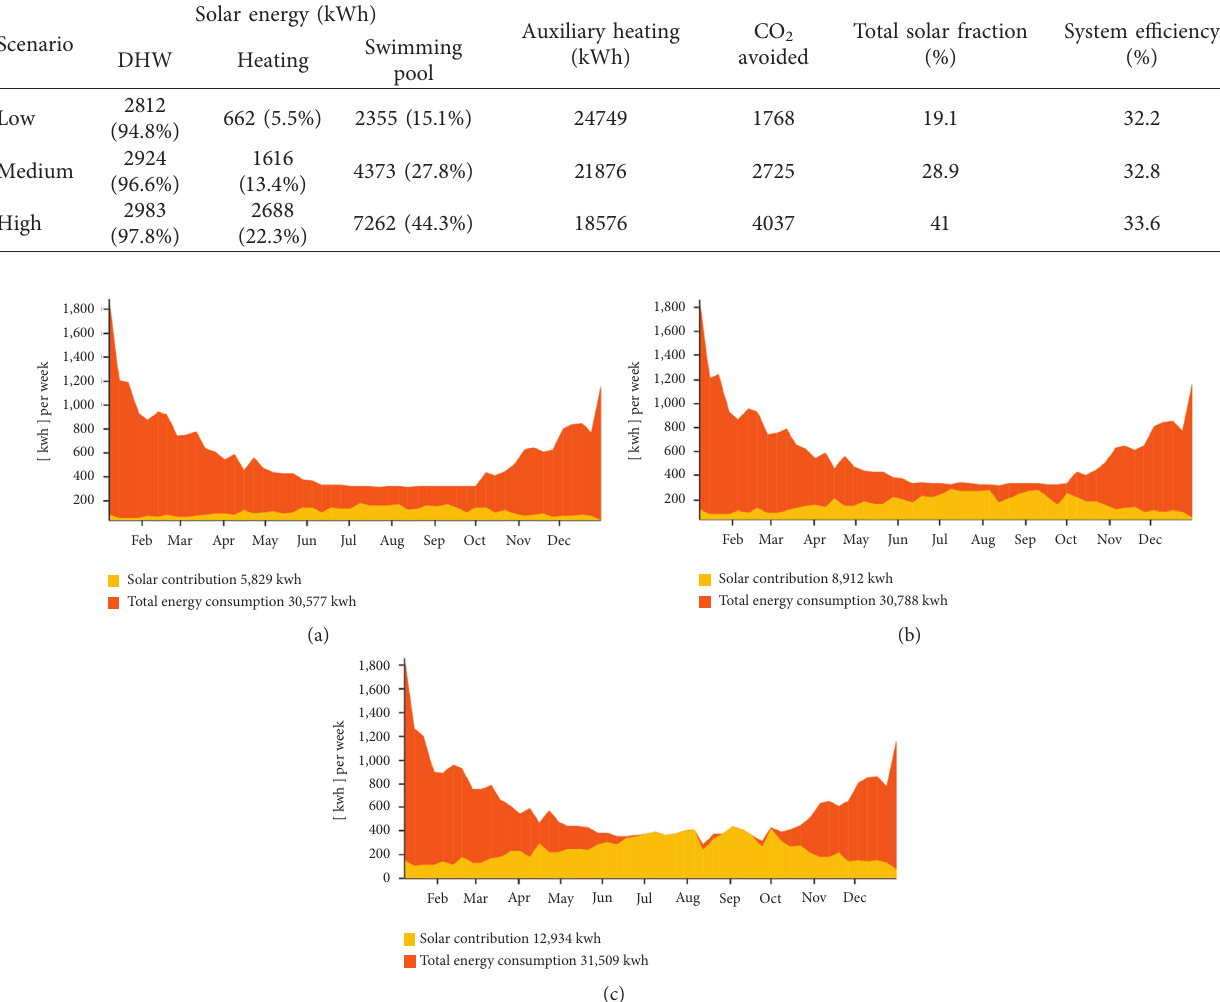
Figure 6: Produced solar heating compared to the total heat required for solar fraction scenarios. (a) Low. (b) Medium. (c)